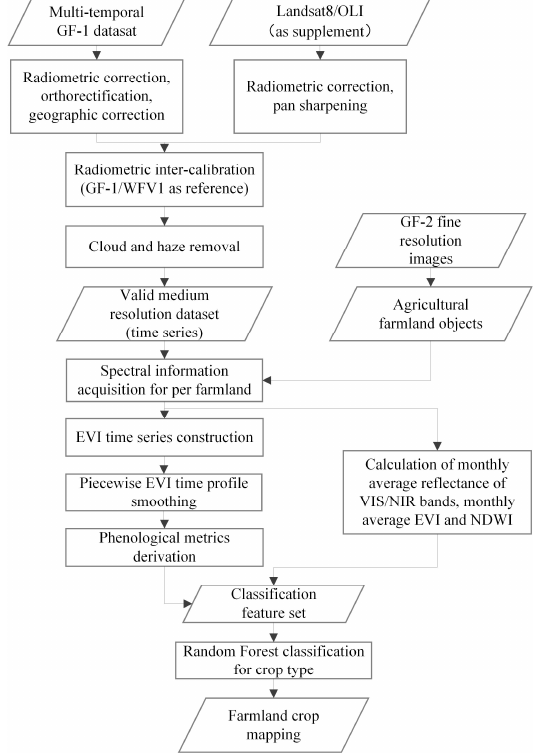
Figure 2. The main steps of using fine-resolution and medium-resolution imagery to classify crops (VIS/NIR (visible and near